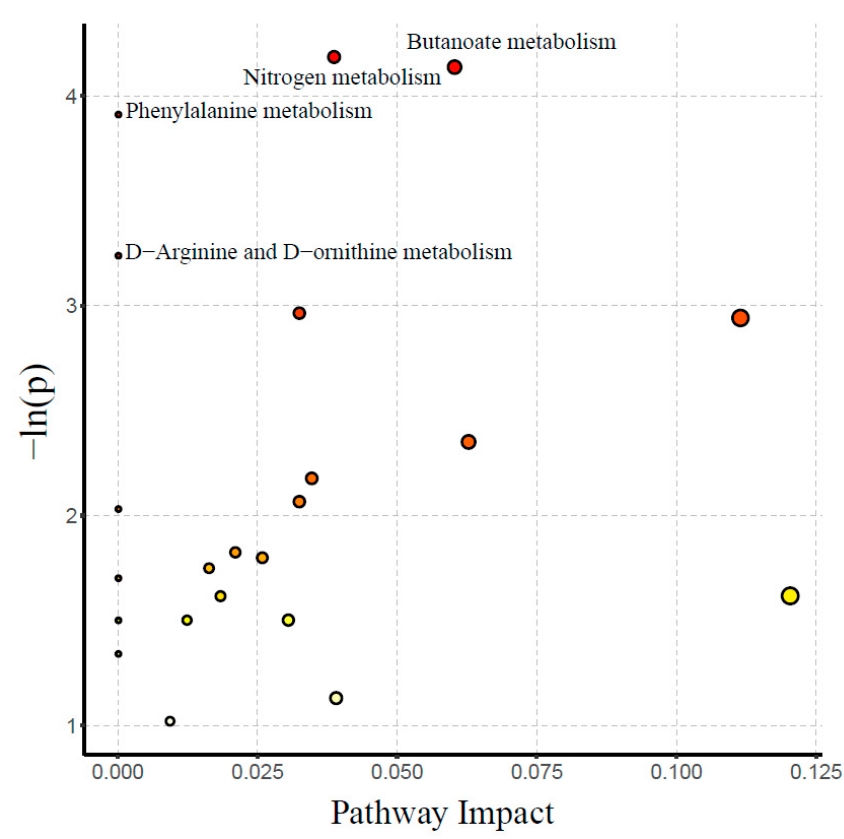
Figure 3. Enriched metabolic pathways based on the screened differential metabolites between the two groups. The color of the point represents the p -value. The redder the point is, the more significant the enrichment is. The size of the point represents the number of enriched differential metabolites. Significantly enriched pathways with a p -value < 0.05 was highlighted.